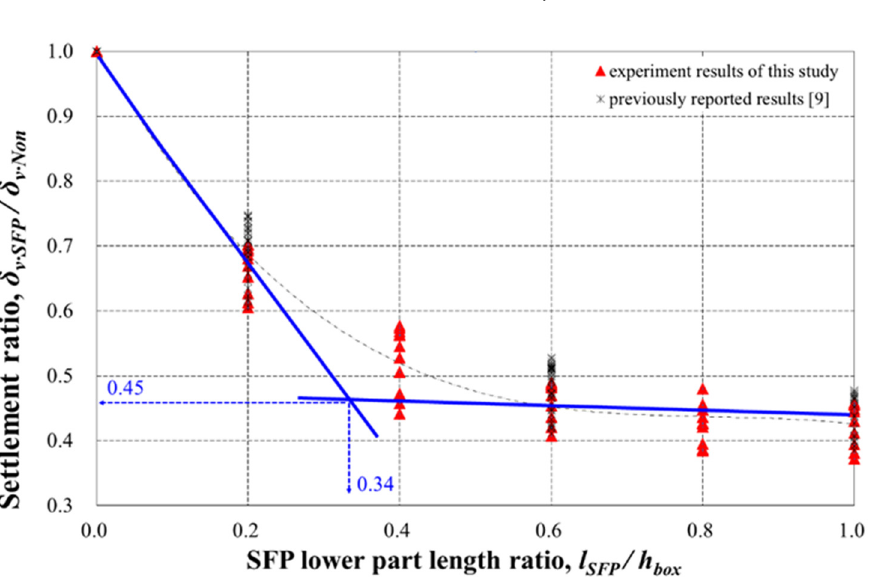
Figure 10. Relationship between the settlement ratio and the ratio of the lower length of the SFP to the box structure